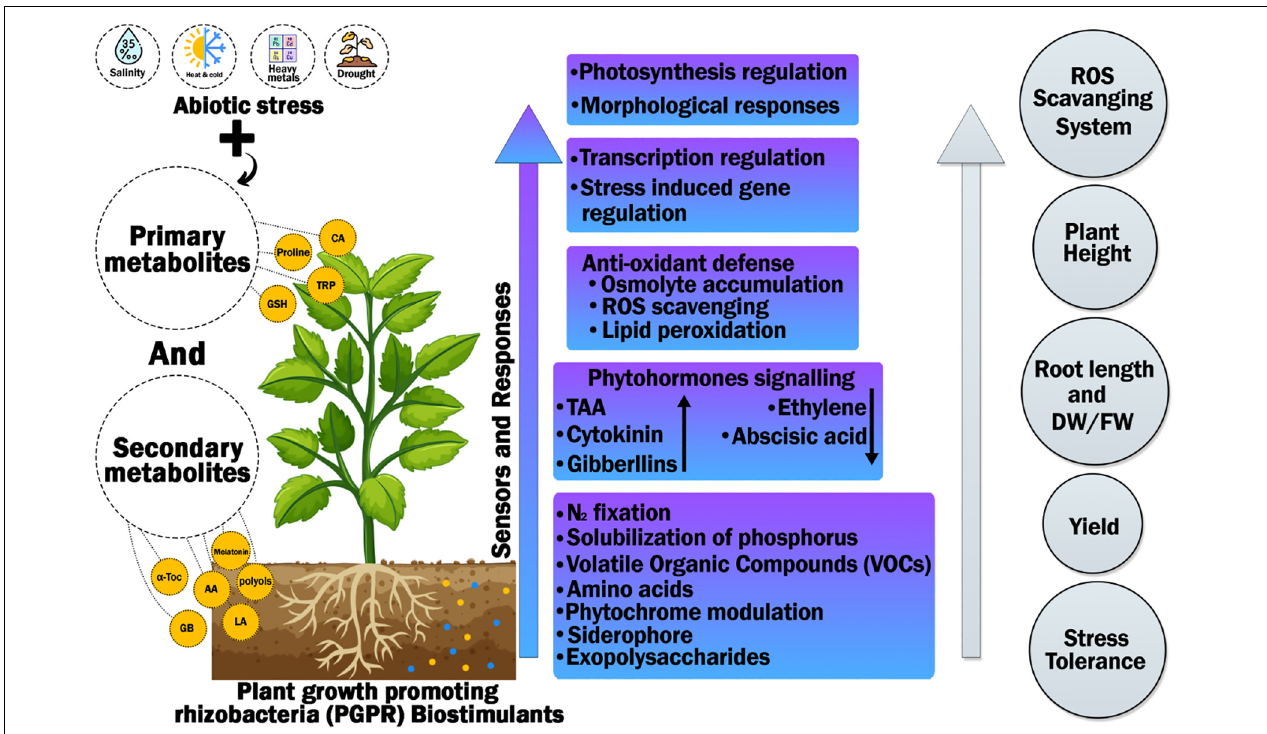
FIGURE 2 | Response of primary and secondary metabolites in plants to various abiotic stresses to help plant in activation defense system and signal